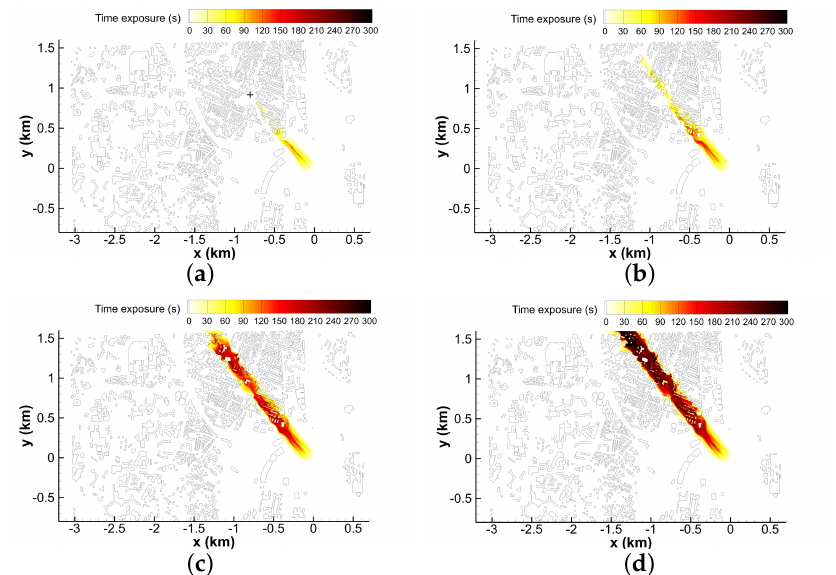
Figure 8. Exposure time (s) near the ground as a percentage of the initial pollutant concentration: ( a ) 20%; ( b ) 10%; ( c ) 4%, and ( d ) 2% from the C4/C2-R3 simulation. The black cross indicates the location of the Jacquier